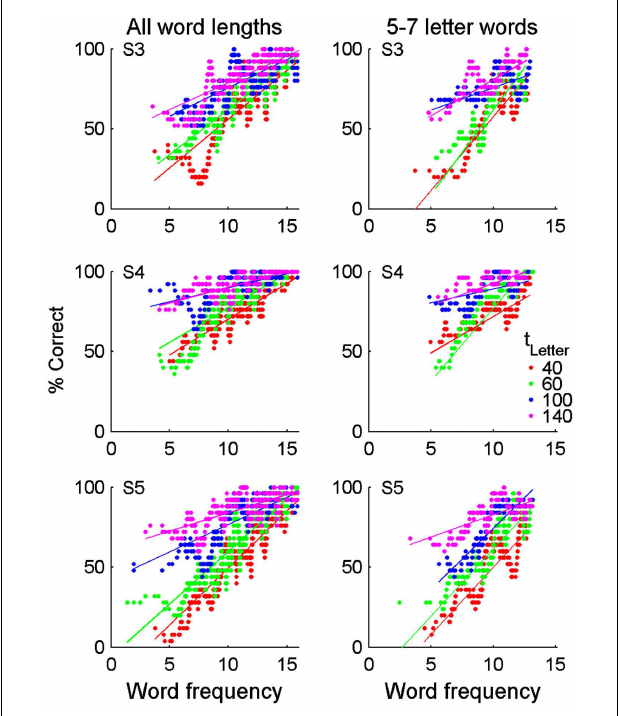
FIGURE 6 | Reading accuracy correlates with word frequency. Words were sorted by their log HAL frequency and then reading accuracy was calculated in a sliding window across groups of 25 words with adjacent frequencies. Each data point thus represents reading accuracy of 25 words with similar frequency. Data is shown for all word lengths (1–12 letters, left column) and restricted to words of 5–7 letters (right column). Restricting the word length removes the confound associated with short and long words having the highest and lowest frequencies, respectively. Correlations between % correct and word frequency were significant ( p < 0.01) when all word lengths were grouped: S3 – r 40 = 0.37, r 60 = 0.37, r 100 = 0.27, r 140 = 0.28; S4 – r 40 = 0.32, r 60 = 0.38, r 100 = 0.21, r 140 = 0.25; S5 – r 40 = 0.43, r 60 = 0.46, r 100 = 0.26, r 140 = 0.22. For words of 5–7 letters, correlations were only significant ( p < 0.05) for the 40, 60, and 140ms presentation rates: S3 – r 40 = 0.32, r 60 = 0.38, r 100 = 0.19, r 140 = 0.20; S4 – r 40 = 0.19, r 60 = 0.42, r 100 = 0.10, r 140 = 0.17; S5 – r 40 = 0.31, r 60 = 0.34, r 100 = 0.30, r 140 =